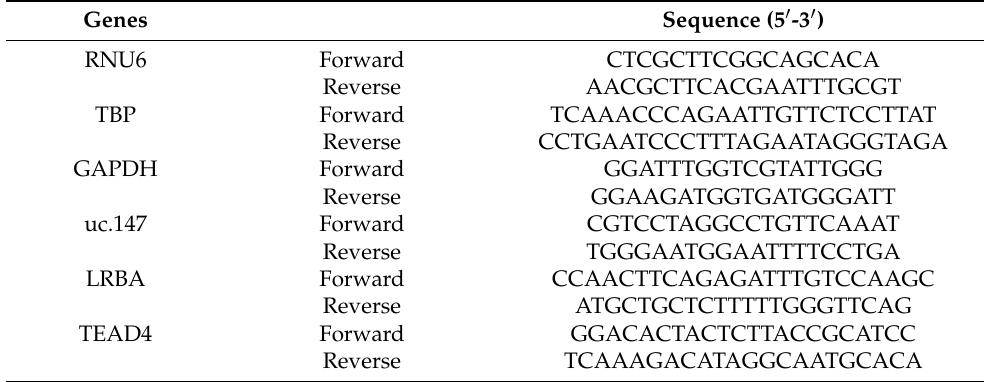
Table 1. Primer sequence used in quantitative real-time